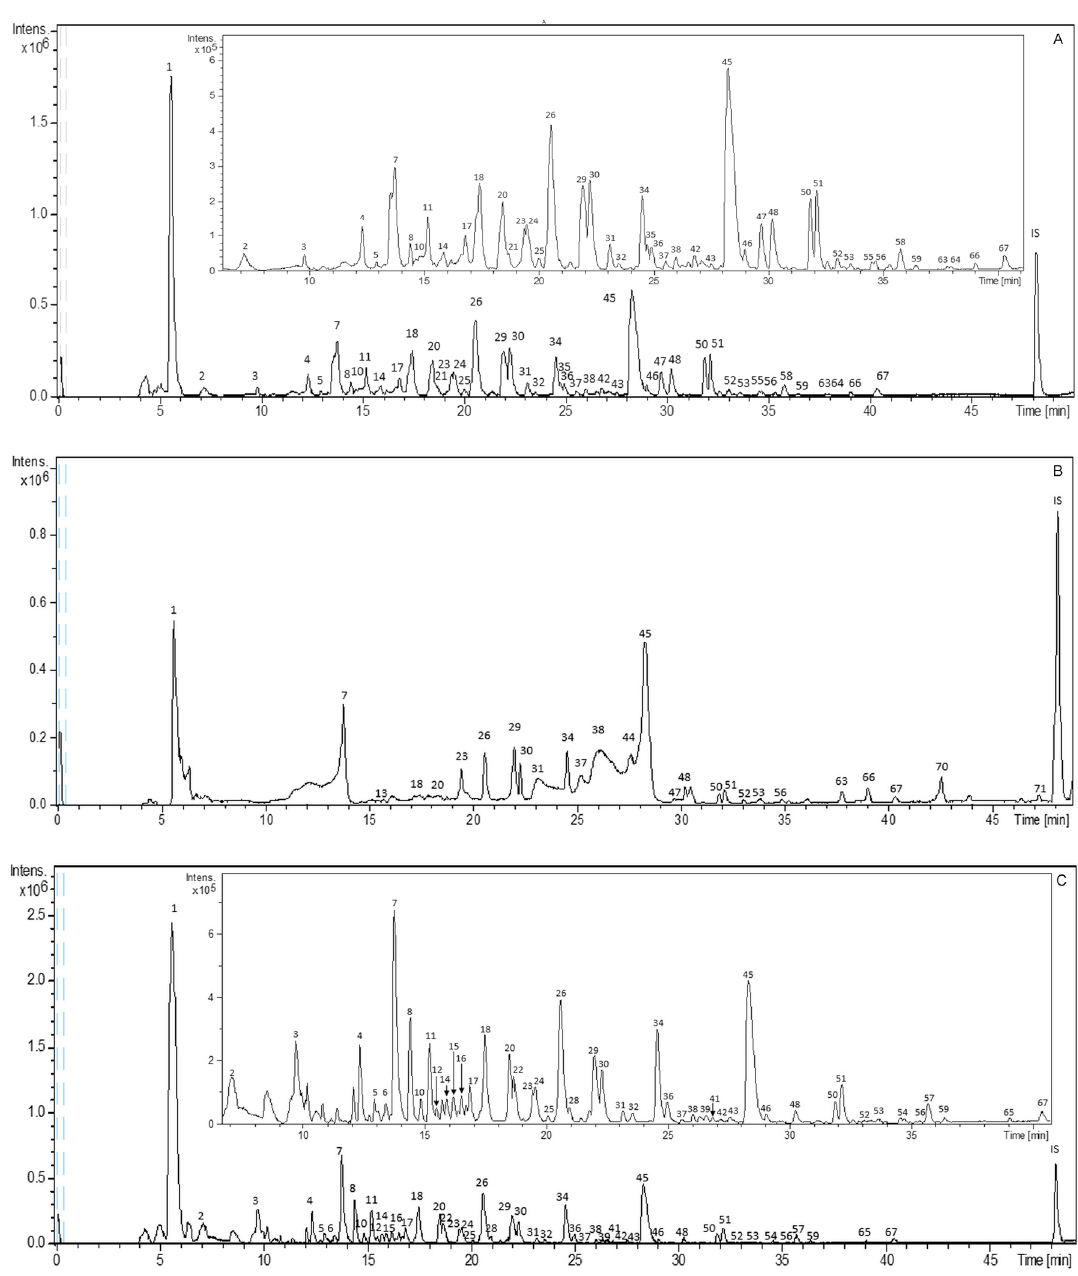
Figure 1. Base Peak Chromatograms (BPCs) of representative Sclerocarya birrea extracts obtained with Figure 1 different extraction techniques: ( A ) solid–liquid extraction (SLE); ( B ) supercritical fluid extraction (SFE), and ( C ) pressurized liquid extraction (PLE). Peak numbers correspond to those of Table